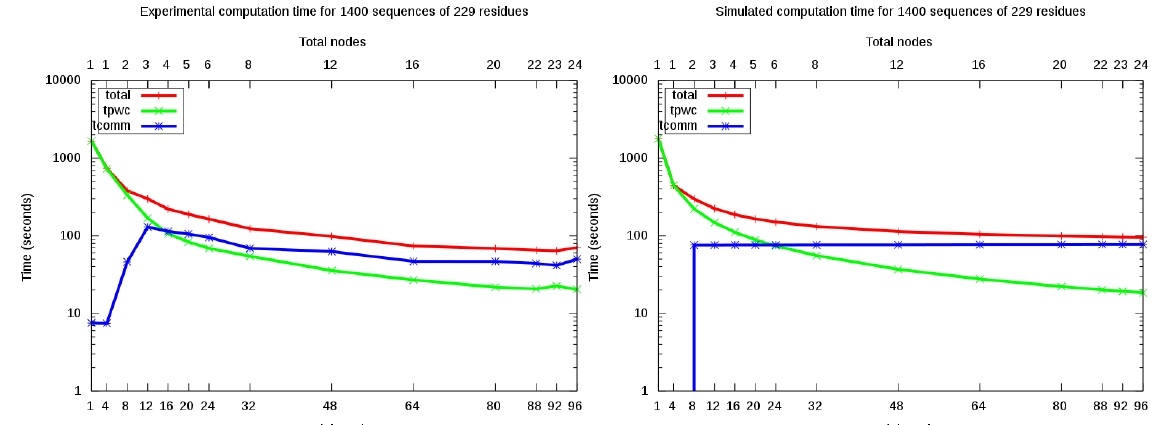
Figure 5: Experimental and simulated execution time of different algorithm